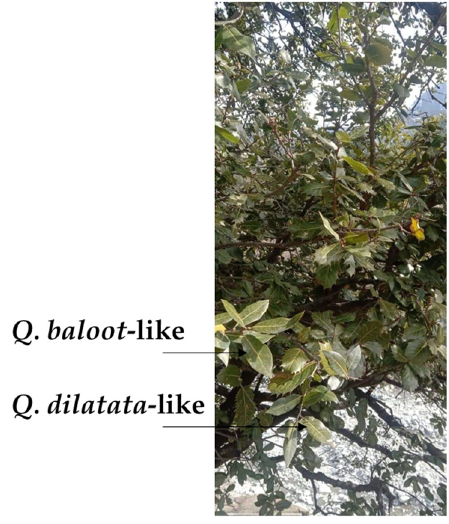
Figure 2. Quercus tree showing mixed Q. baloot Griff. and Q. dilatata Royle leaves. The photo was provided by Muhammad Khalil Ullah Khan.